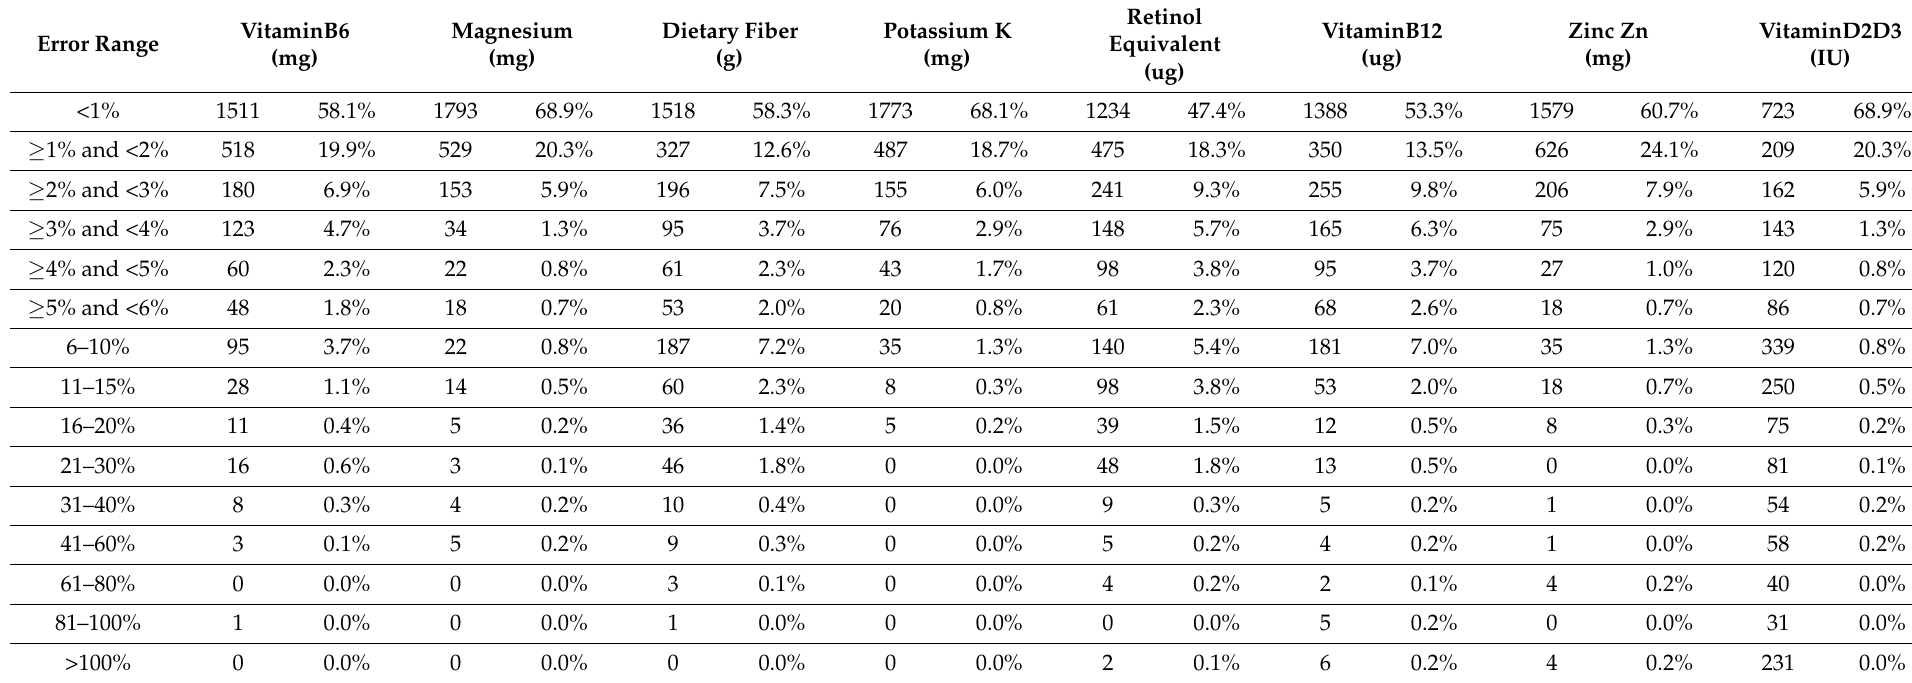
Table 3. Discrepancy comparison table of NNHS analysis with the results of this study in the sum_nutrients_24h